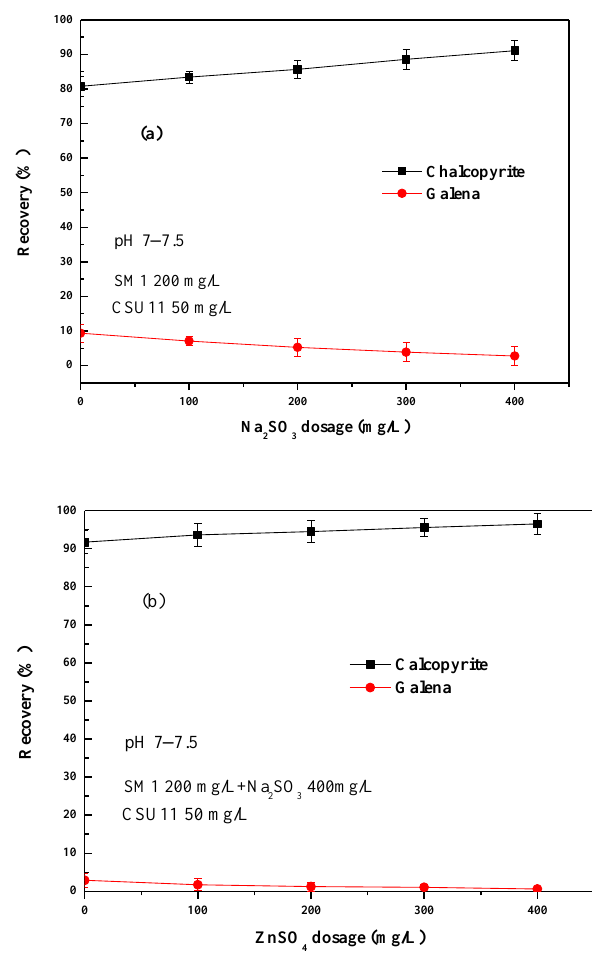
Figure 5. ( a ) Effect of Na 2 SO 3 dosage on single mineral flotation behavior; ( b ) Effect of ZnSO 4 dosage on single mineral flotation behavior.